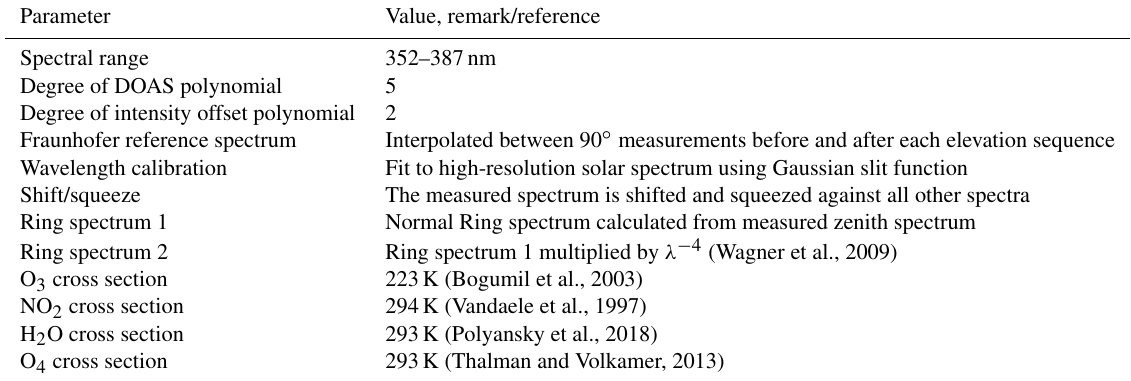
Table 1. Settings for the DOAS analysis of O 4 . Parameter Value, remark/reference Spectral range 352–387nm Degree of DOAS polynomial 5 Degree of intensity offset polynomial 2 Fraunhofer reference spectrum Interpolated between 90 ◦ measurements before and after each elevation sequence Wavelength calibration Fit to high-resolution solar spectrum using Gaussian slit function Shift/squeeze The measured spectrum is shifted and squeezed against all other spectra Ring spectrum 1 Normal Ring spectrum calculated from measured zenith spectrum Ring spectrum 2 Ring spectrum 1 multiplied by λ − 4 (Wagner et al.,